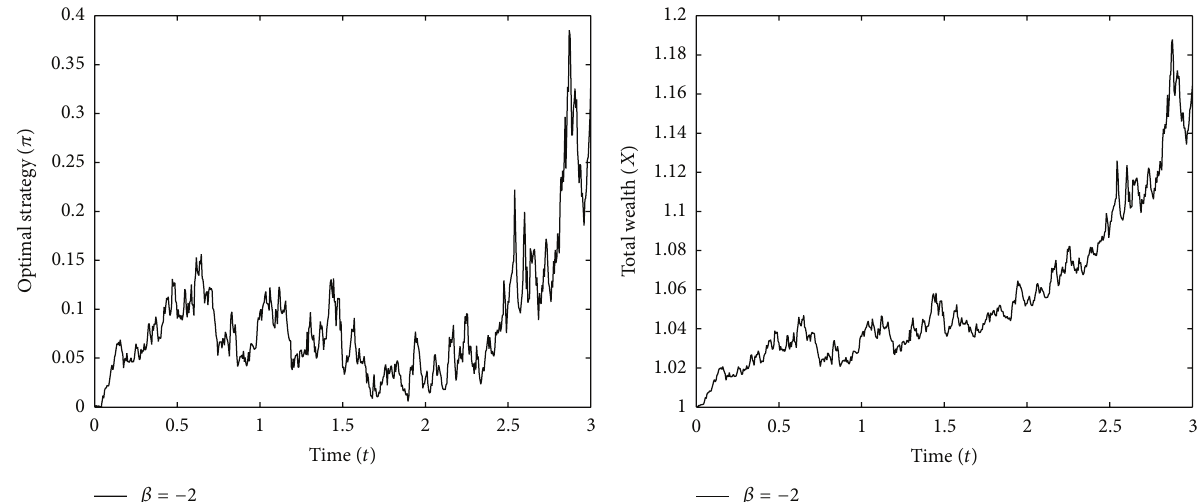
Figure 10: The evolutions of optimal strategy and total wealth over time ( 𝛽 = −2 ).